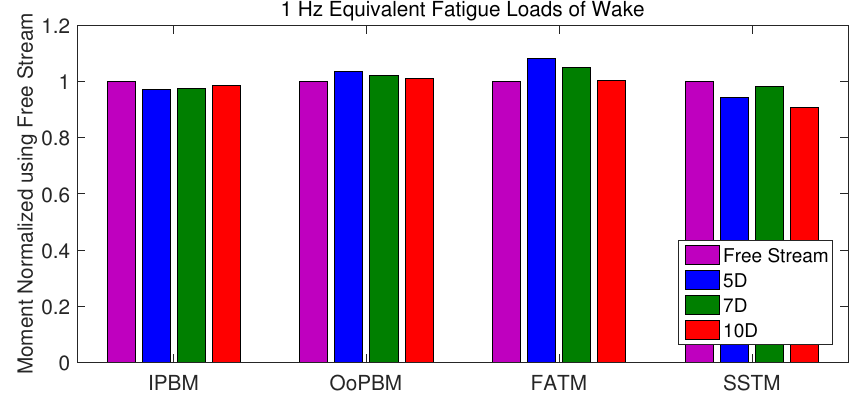
Figure 30. Normalized 1 Hz equivalent fatigue loads of wake.